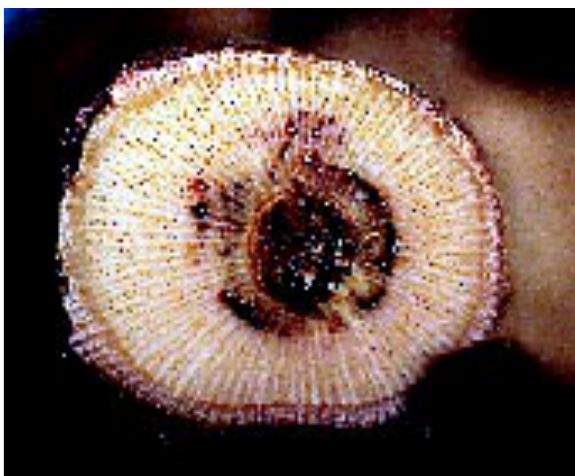
(right).Fig. Fig. 2. Black goo in the pith and inner xylem of a 5C rootstock Fig. 3. Black goo caused by P. chlamydosporum seen in the cross-section of a circa 13-year-old, certified 420A mother vine in California. Note the healthy tissue in the outer xylem rings (left). Longitudinal view of black goo inside the 420A mother vine in Fig. 3 on the left. Note the heavy black line at the intersection of live with dead wood